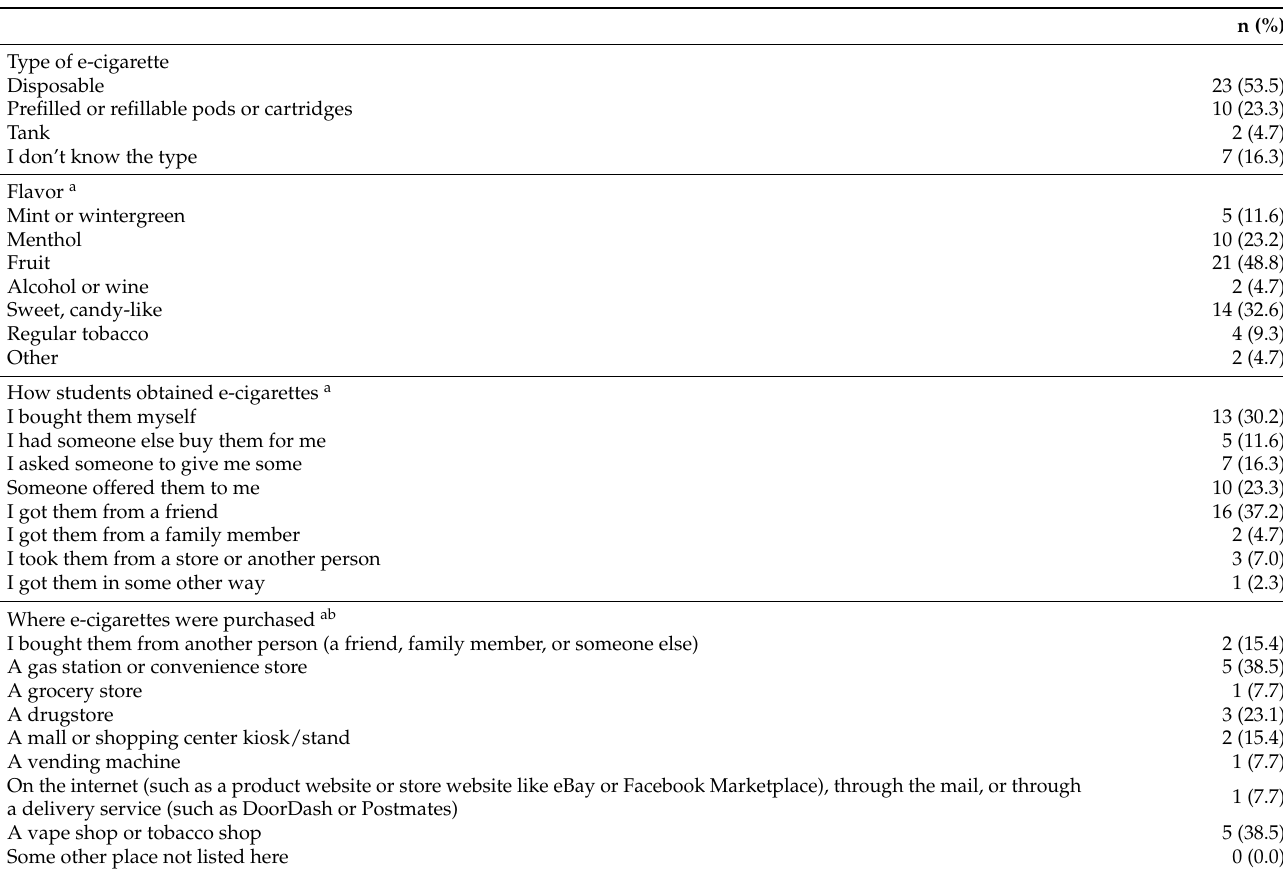
Table 4. E-cigarette use behaviors among students who used e-cigarettes in the past 30 days, NJYTS 2021 (n = 43).